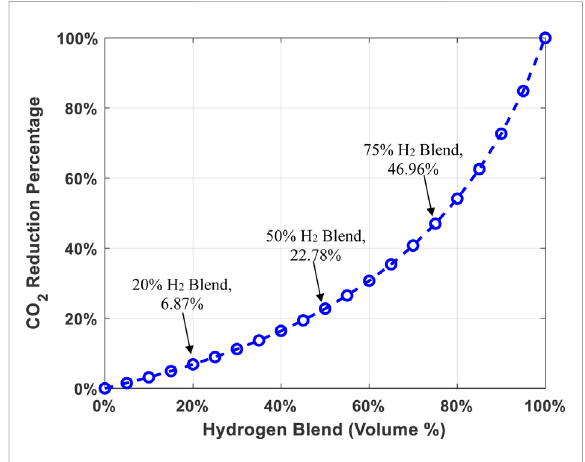
FIGURE 4 CO 2 Reduction with respect to hydrogen and methane blend percentages, for example, if methane is blended with H 2 at 20%, 50%, or 75% by volume, the carbon emission reductions per unit energy of the blended gas will be approximately 7%, 23%, and 47%,